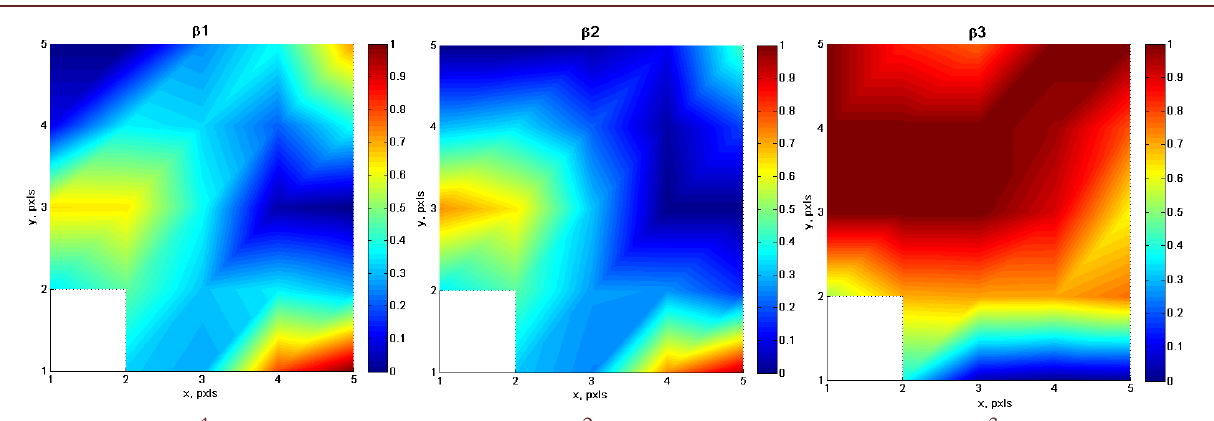
Figure 8: The first coordinate quarter of the space β -distribution at different time moments is shown in Fig. 7. The crack propagates along the x